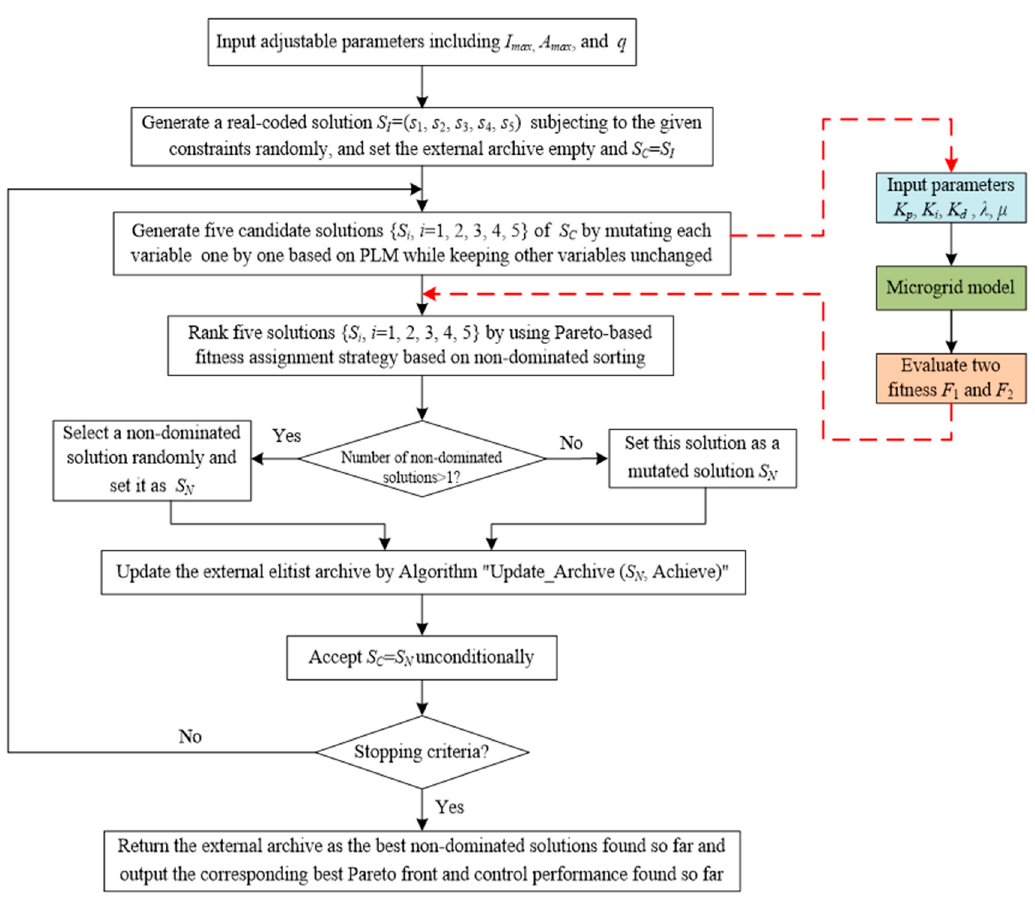
Figure 4. Flowchart of the proposed MOEO-FOPID method for the frequency control of microgrids. MOEO-FOPID-Based Frequency Controller Optimal Design Algorithm for an Islanded Microgrid Input: A microgrid system with a FOPID-based frequency controller and adjustable parameters used in the MOEO-FOPID algorithm, including the maximum number of iterations I max , the maximum size of external archive A max , and the shape parameter q used in mutation operation. Output: The best non-dominated solutions for the designed FOPID-based frequency controller and the corresponding best Pareto front found so far.